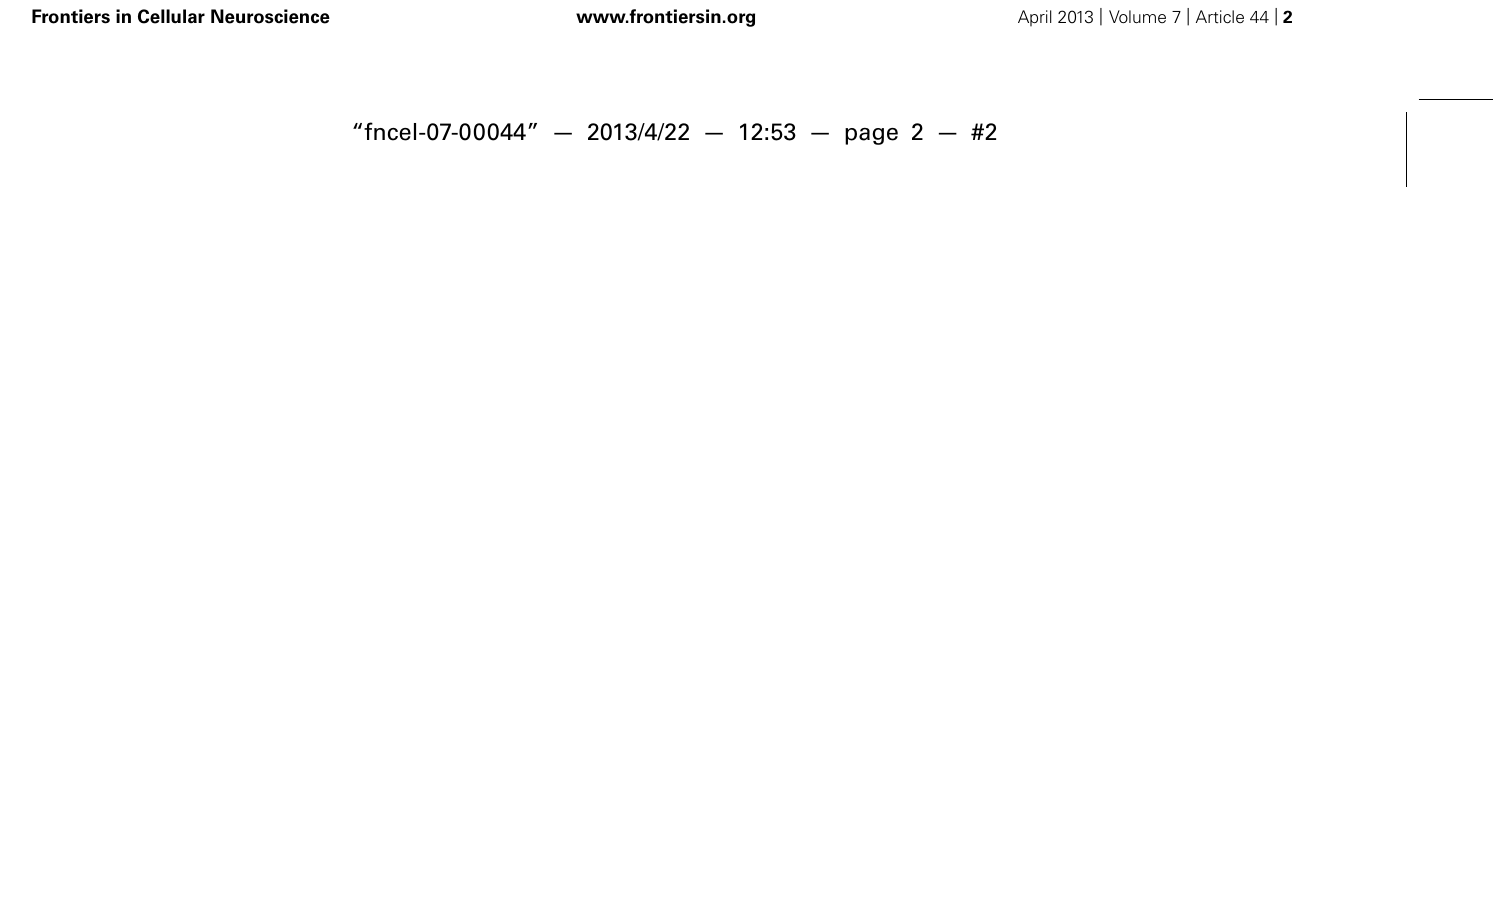
FIGURE 1 | Exogenous signals and their receptors on microglia. Microglia are equipped with a group of surface receptors which trigger signals in microglia under “resting” conditions. Many of these signals are ligands which are released or expressed on the surface of neurons. Inhibitory receptors like CX 3 CR1, CD200R, and CD172a/Sirp alpha have their ligands on the surface of healthy neurons. A loss of the signal also indicates a loss of neuronal integrity.